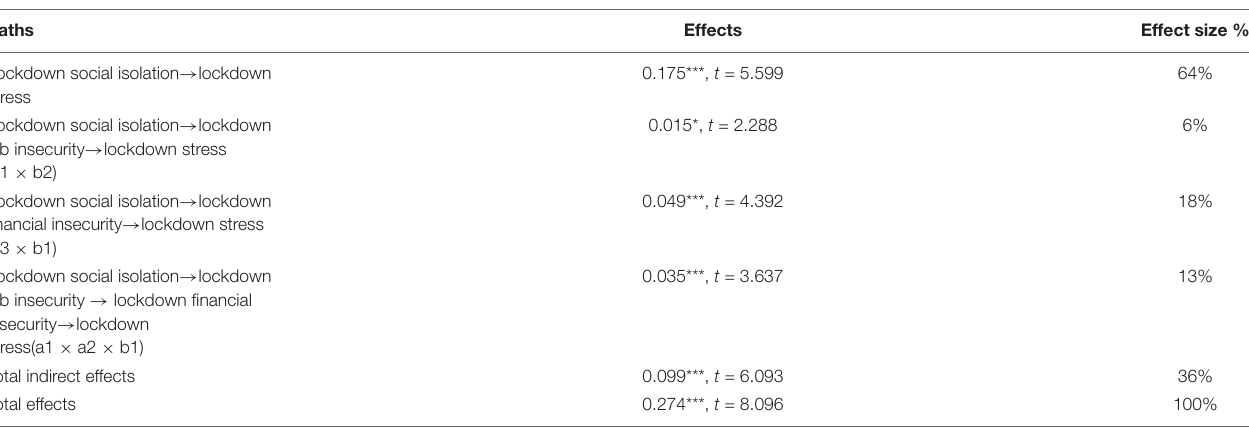
TABLE 3 | Demonstration of the direct, indirect, and total